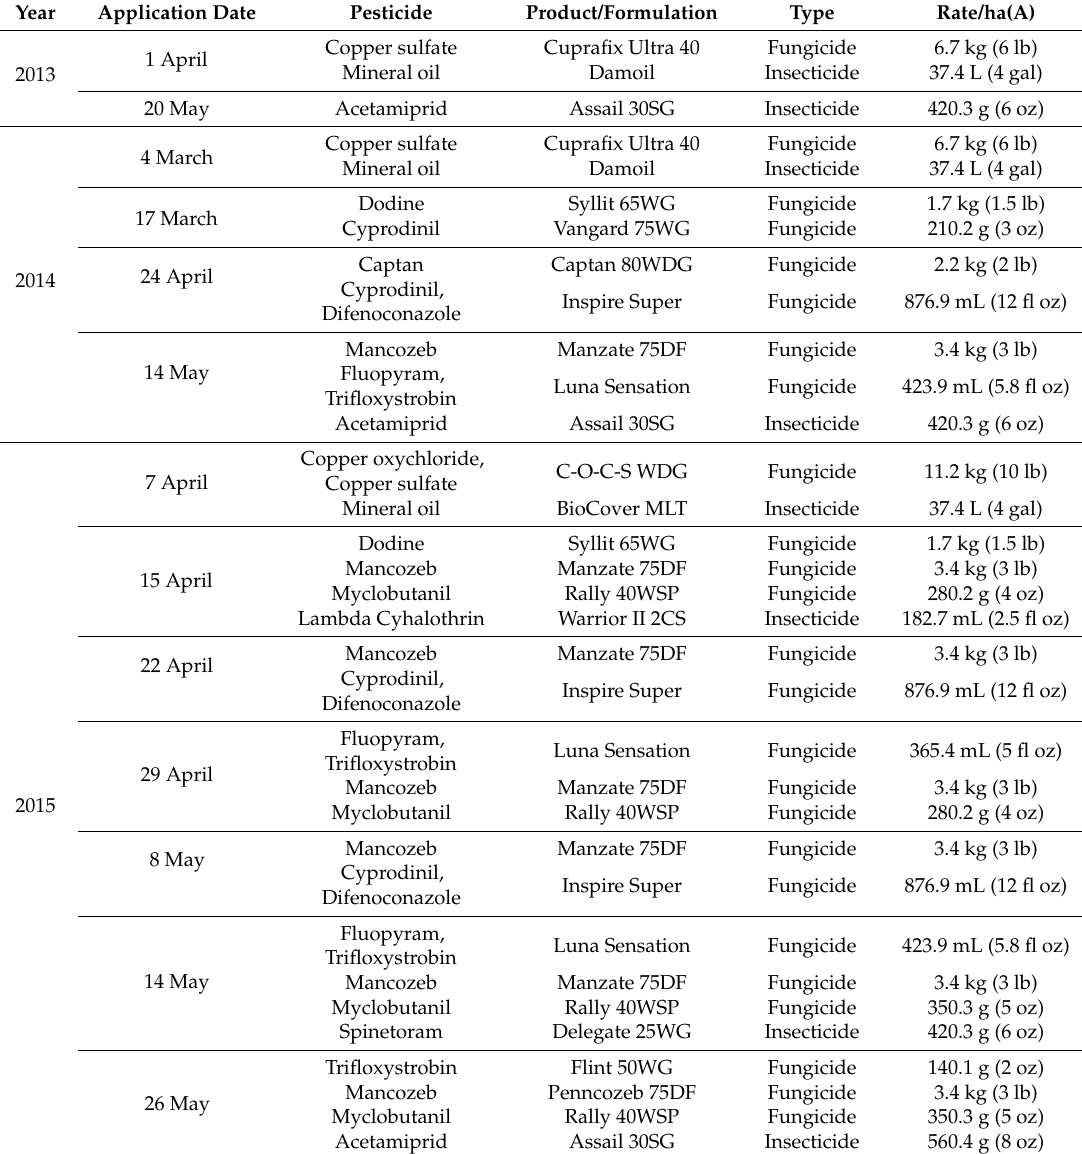
Table 1. Application date, pesticide, product/formulation, type, and application rate for the early season pest management spray program,